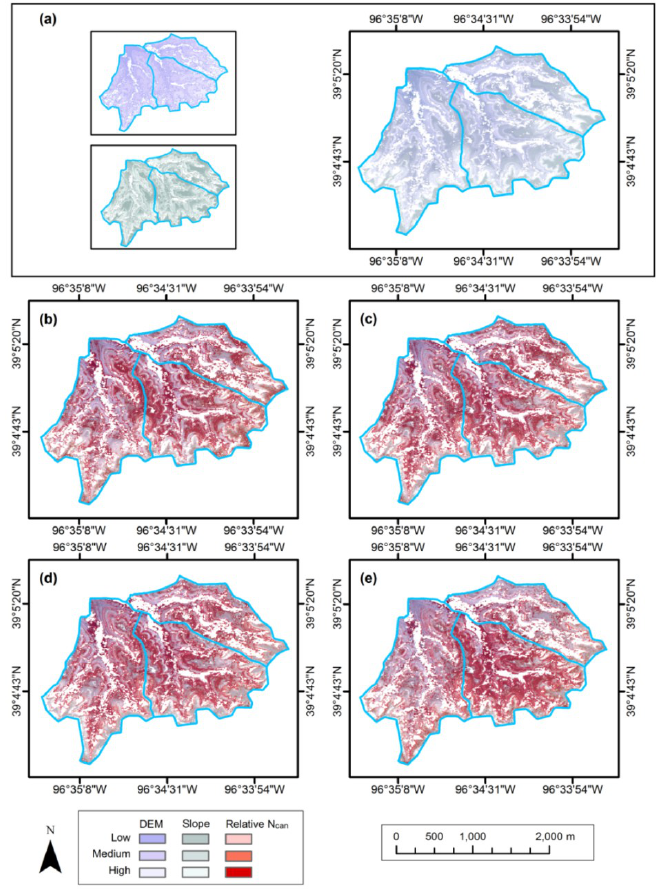
Figure 8. Comparison between N can stratification and ( a ) DEM in selected watersheds at KPBS in ( b ) May, ( c ) July, ( d ) August, and ( e ) September. Hillslopes are highlighted in the light shade, and flat lowlands are in the dark shade. Coincidence between N can distribution patterns and topographic features is most noticeable in